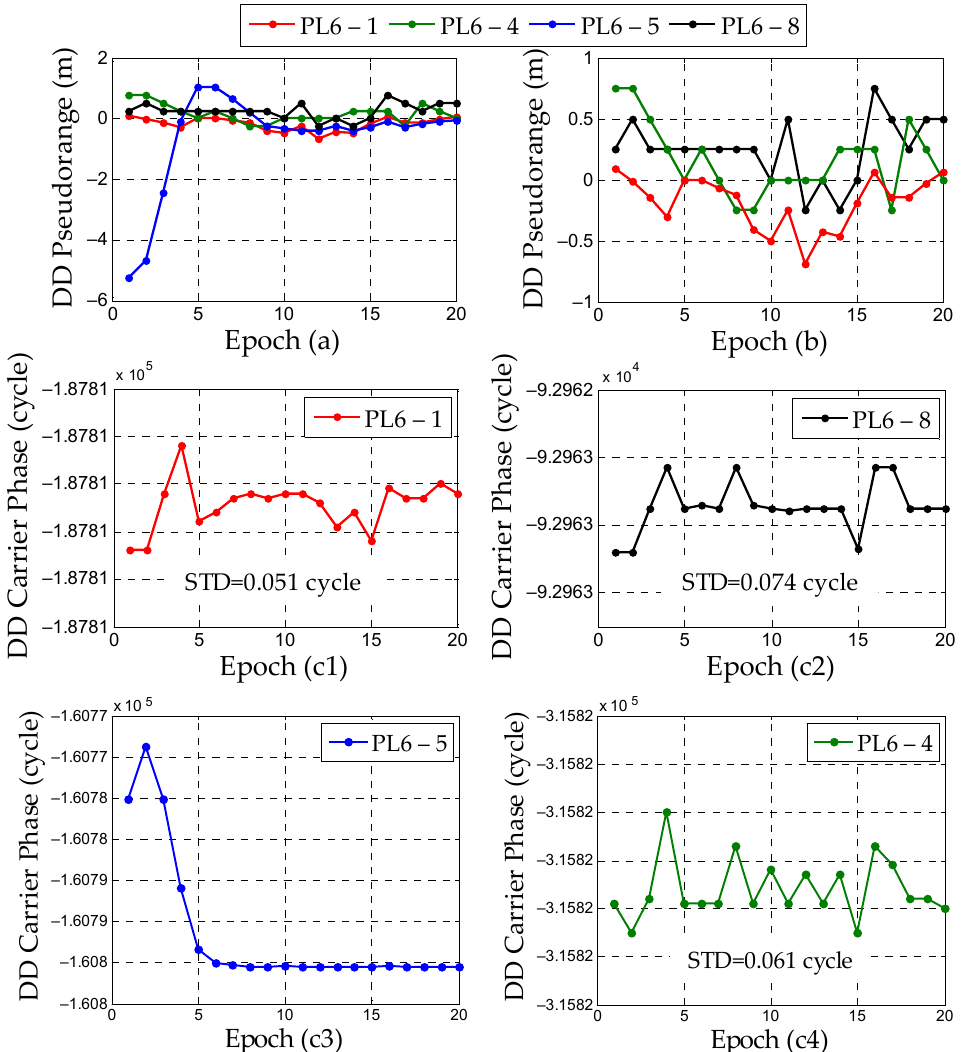
Figure 7. ( a ) DD Pseudorange Observations after Using Strategy 1, ( b ) DD Pseudorange Observations after Using Strategy 2, ( c1 – c4 ) DD Carrier Phase Observations after Using Strategy 1.